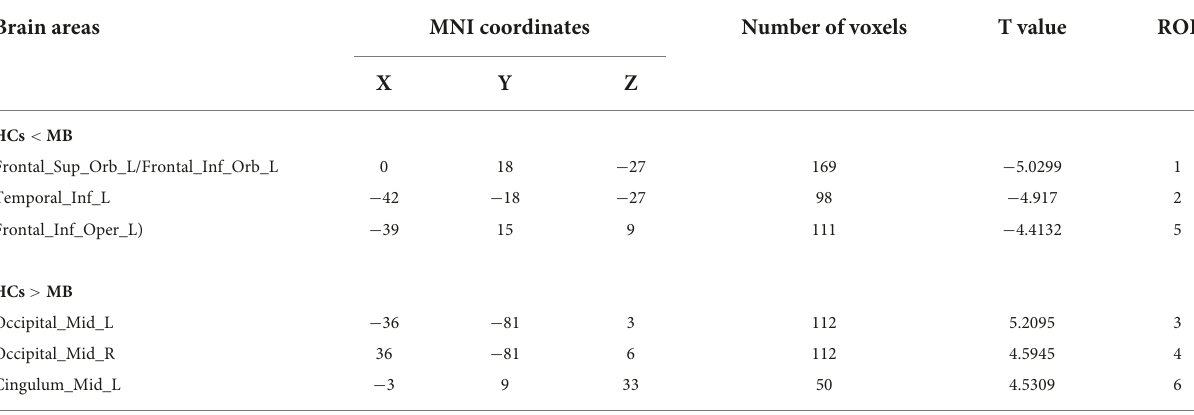
TABLE 2 Brain areas with significantly different PerAF values between MB and HCs.